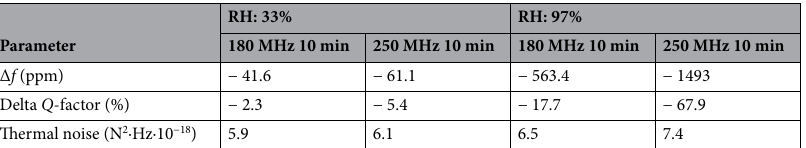
Table 2. Comparison of device key parameters of 180 MHz_10 min and 250 MHz_10 min sensors under 33 and 97% RH conditions.